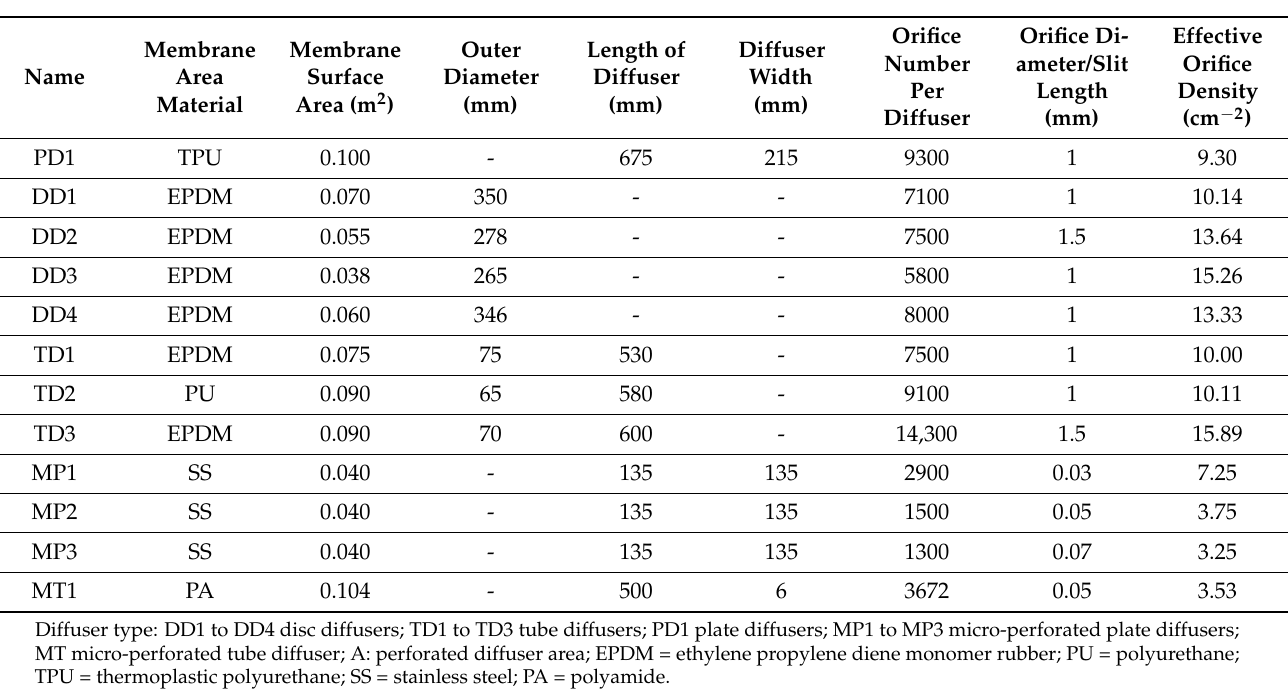
Table 1. Characteristics of investigated diffusers.